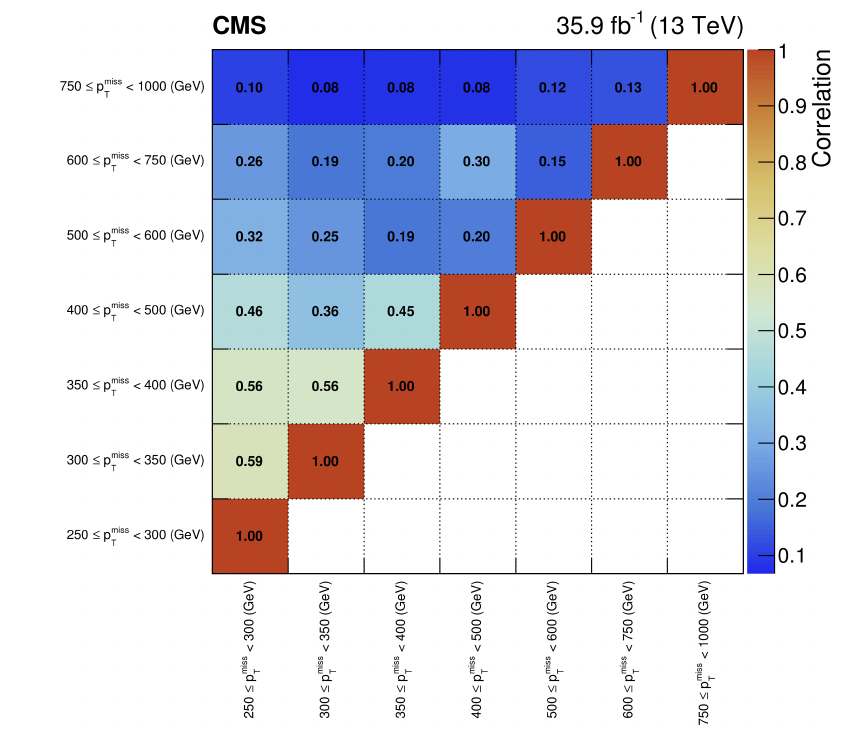
Figure 2. Example of the V matrix for an exotica search analysis in final states with an energetic jet or a hadronically decaying W or Z boson and transverse momentum imbalance. It shows the correlations between the predicted background yields in all the missing E T bins for one of the signal regions of the analysis. The boundaries of the E T bins, expressed in GeV, are shown at the bottom and on the